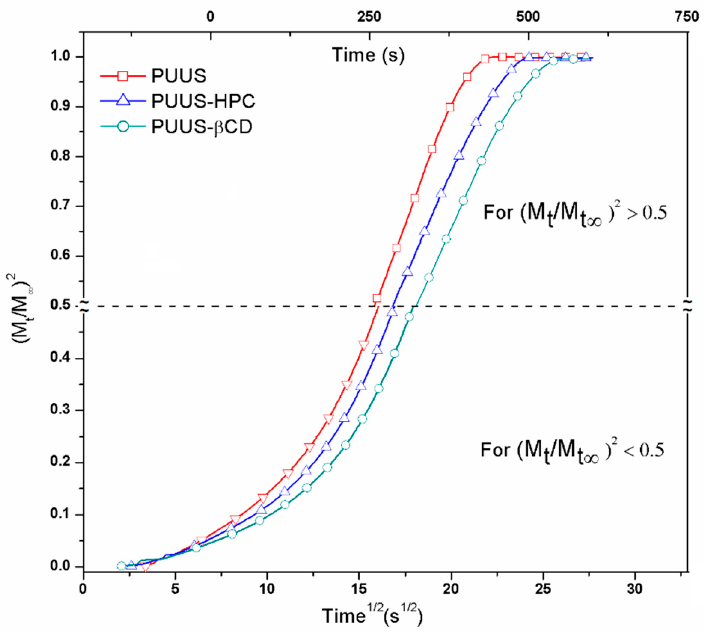
Figure 8. Diffusion plots for nanofibrous mat (PUUS) and nanofibrous composite mats (PUUS-HPC and PUUS- β CD).